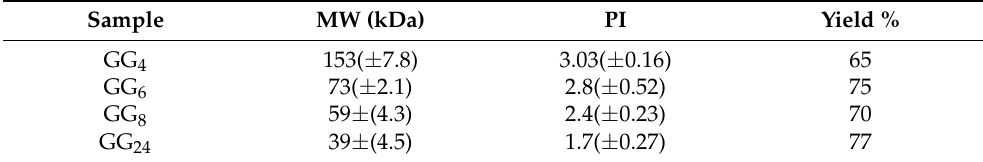
Table 1. The table report molecular weights, polydispersity index and yield % of obtained